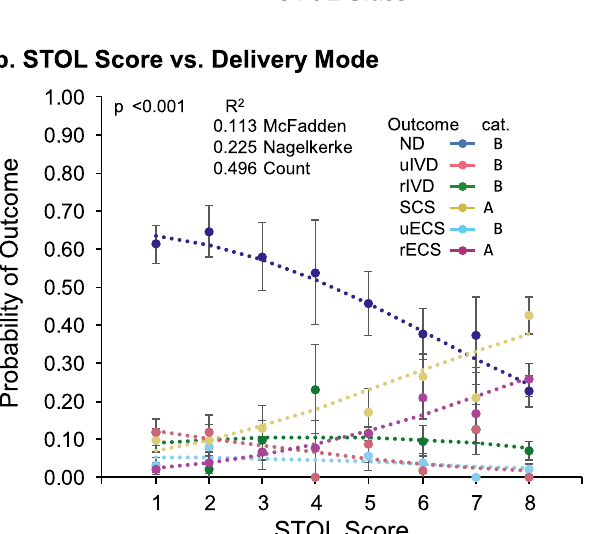
better predictive method than Magnin is ambiguous.